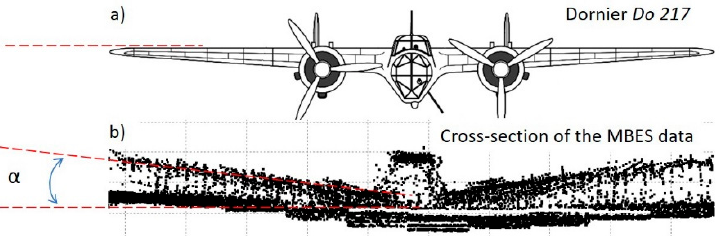
Figure 15. Comparison of the wing arrangement and wingspan: ( a ) wing arrangement of the Do 217; ( b ) wing arrangement of the discovered wreck of plane, vertical cross-section of the multibeam echo sounder data.